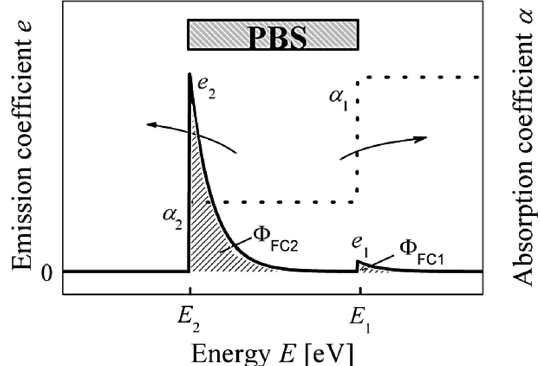
Fig. 2. Sketch of the absorption and emission behavior as as- sumed in this paper. The dye absorption is given by a step function. Incoming photons have the energy E 1 and a high absorption coefficient α 1 . The lower absorption coefficient α 2 holds for the lower energy E 2 and leads with Kirchhoffs law (Eq. (1)) to a high emission coefficient e 2 . The model also fea- tures the possibility of an energy selective photonic band stop (PBS) that keeps the emitted photons in the FC